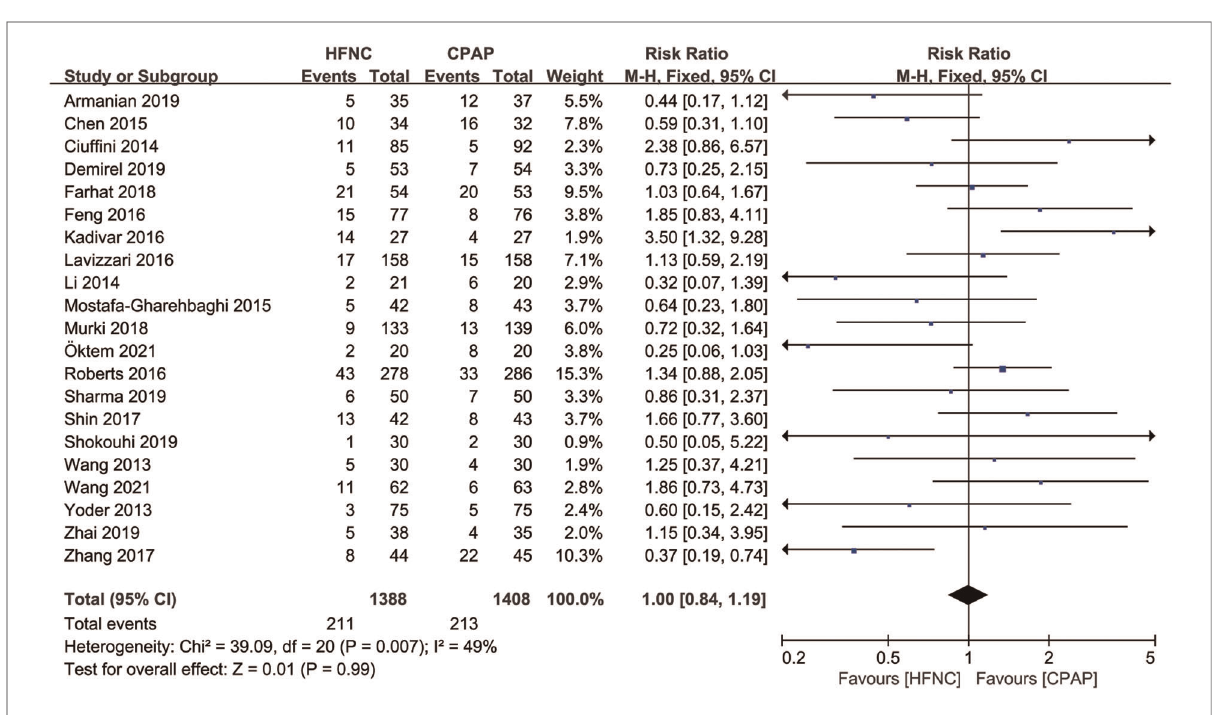
FIGURE 5 Forest plot of comparison: HFNC vs. CPAP-number-mechanical